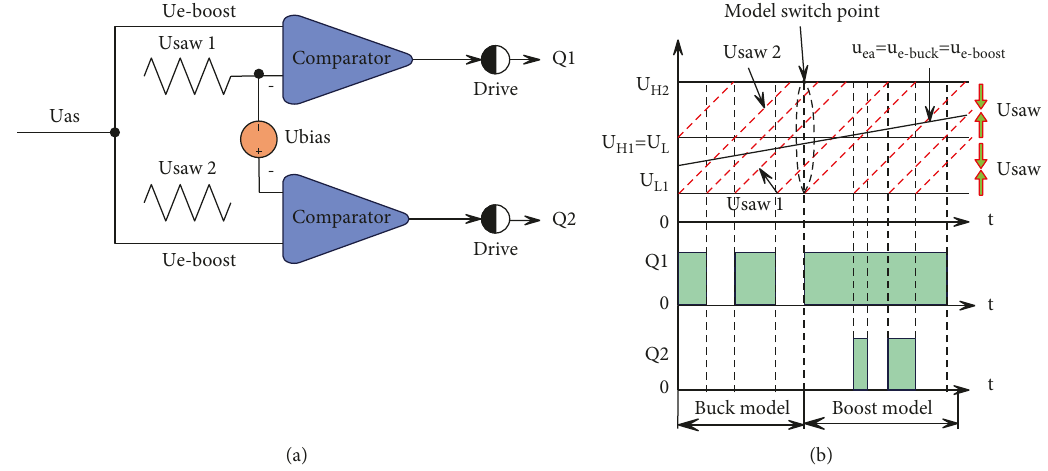
Figure 1: Double-tube buck-boost power conversion circuit single modulation signal-dual carrier two-mode control mode: (a) schematic diagram of control strategy; (b) main working